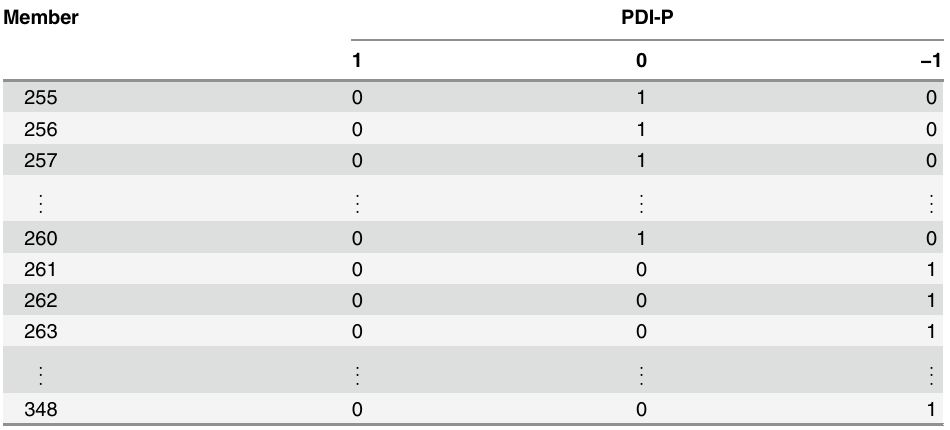
Table 14. A decomposition of Table 10 into multi-tables of Boolean-Valued for PKS. Member PKS 1 0 − 1 349 1 0 0 350 0 0 . .. . .. . .. . .. 403 0 0